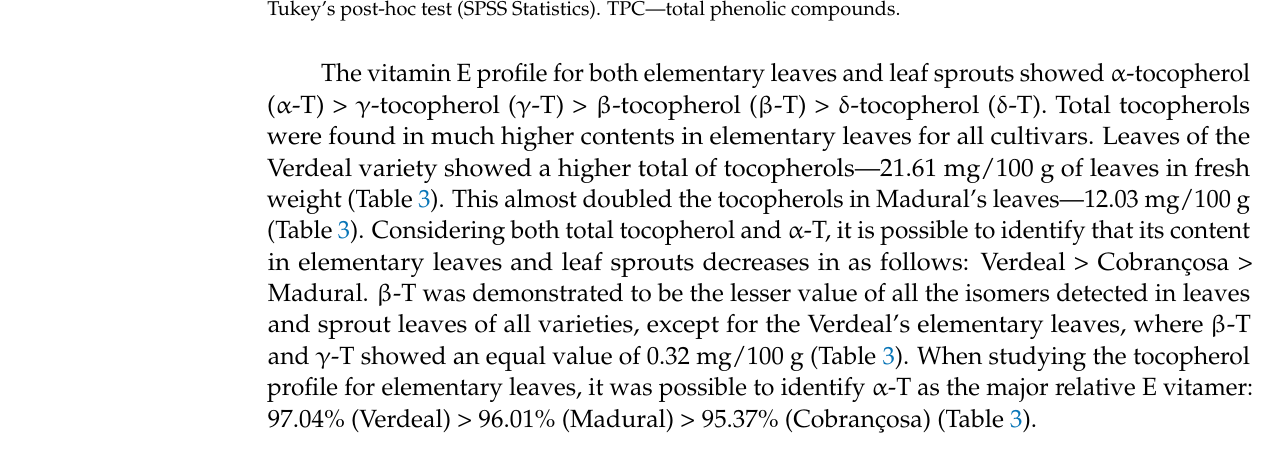
Table 3. Vitamin E profile of different varieties of olive